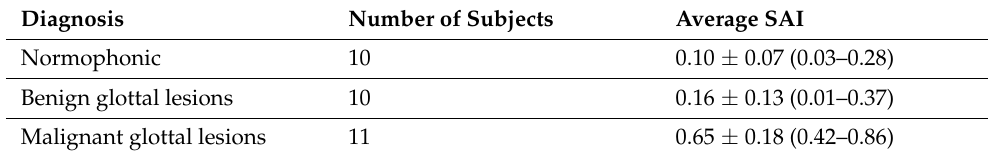
Table 2. Values of SAI for each subject group.